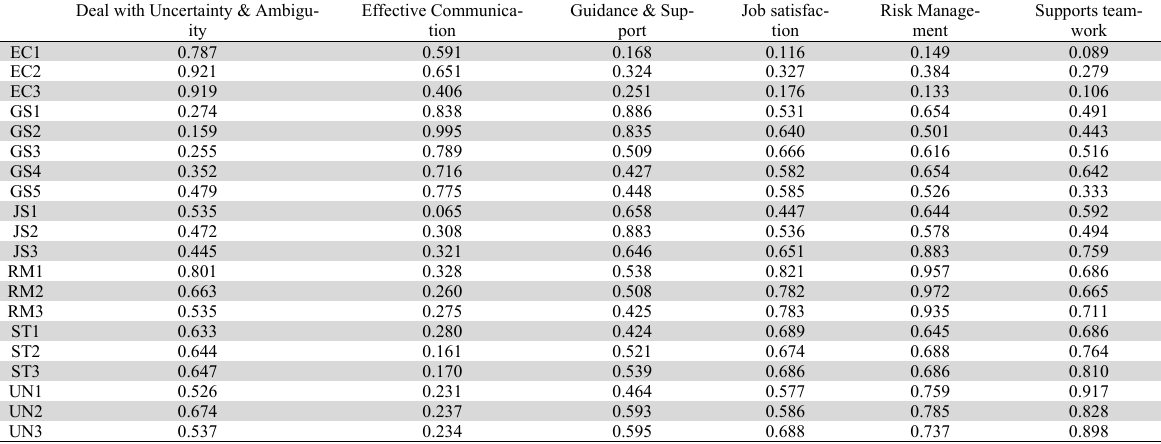
Cross Loading Criterion for Discriminant Validity Deal with Uncertainty & Ambigu- ity